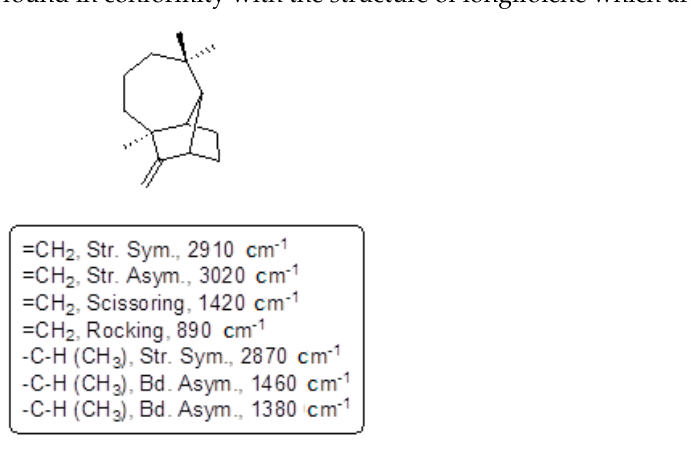
Figure 1. Wave numbers of different functional groups of isolated compound ‘X’.